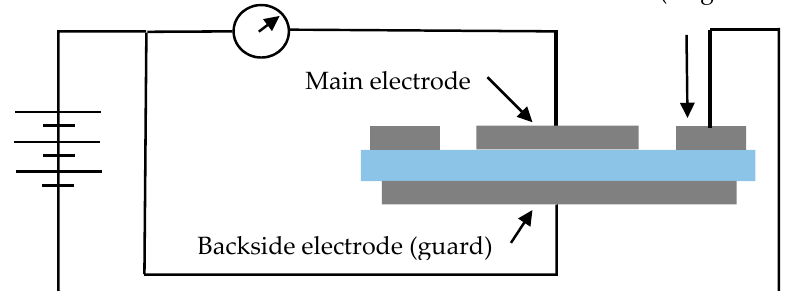
Figure 4. Surface resistivity measurement following the ASTM D257.